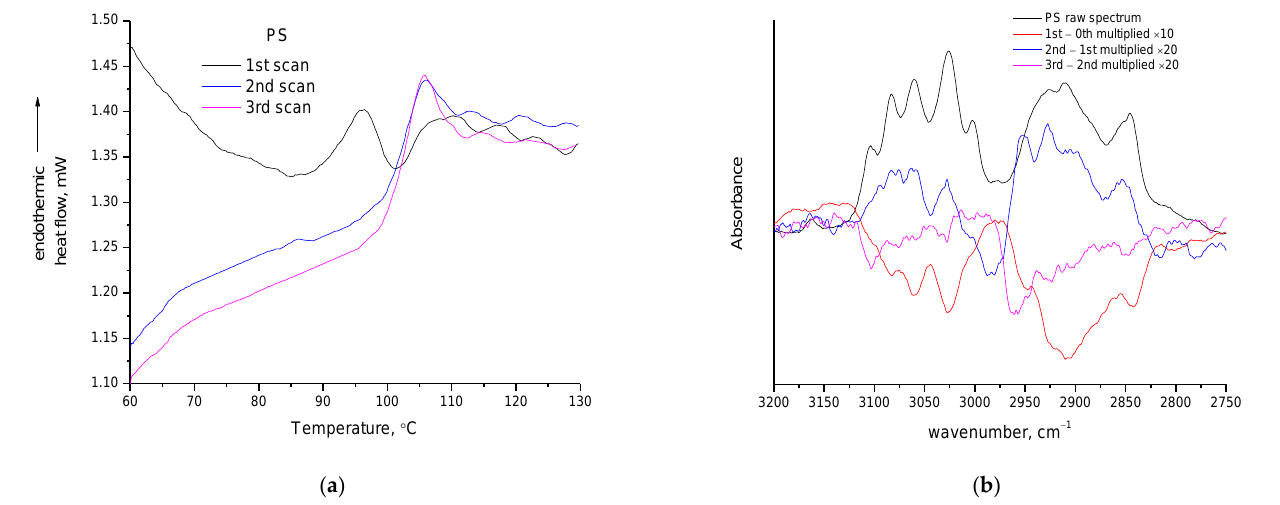
Figure 10. ( a ) Three consecutive DSC scans of the PS sample; ( b ) FTIR spectrum of PS raw material and subtracted spectra before and after three consecutive heating cycles at 130 °C in the region 3200–2750 cm −1 .